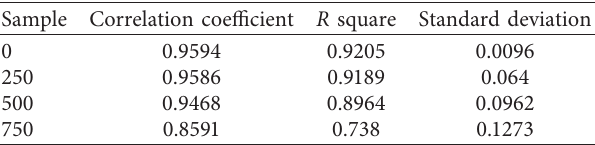
Table 5: Correlation and regression analyses between TAN and working hours of